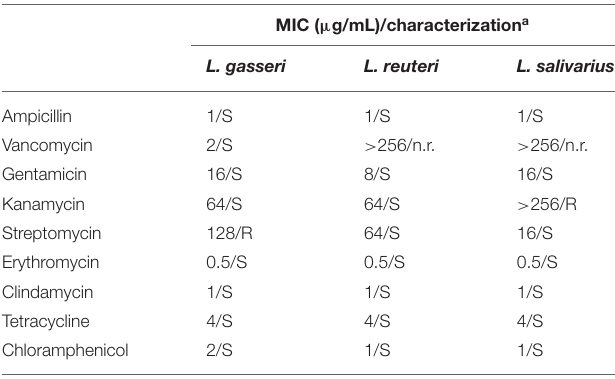
TABLE 4 | Antibiotics resistance profiles of the Lactobacillus isolates and the respective minimum inhibitory concentration (MIC).